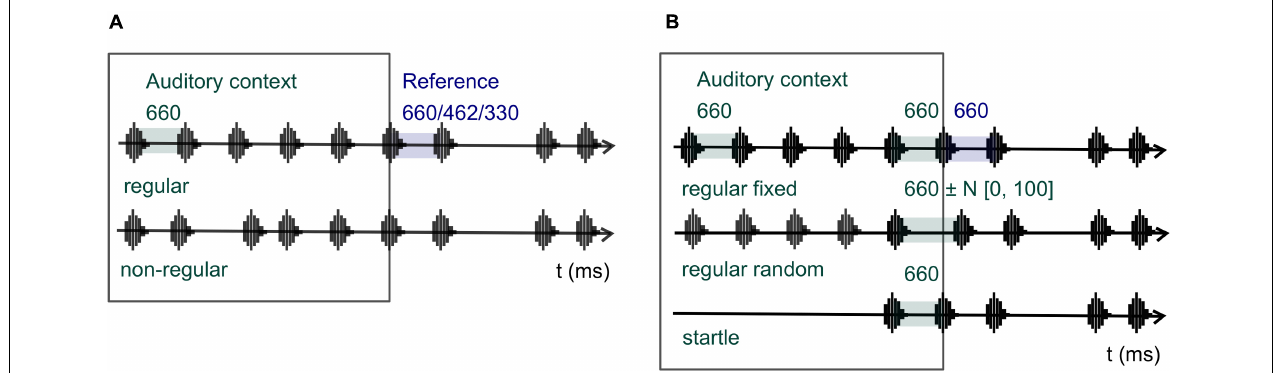
FIGURE 2 | Stimuli of Experiment 1 (A) and Experiment 2 (B) : auditory context made of low-frequency sounds (regions surrounded by squares) and two pairs of high-pitched sounds delimiting the reference and the comparison intervals. The variables of Experiment 1 were auditory context (regular and non-regular) and Reference (660, 462, and 330 ms). In Experiment 2 only auditory context (regular fixed, regular random, and startle) was manipulated, while the duration of the reference interval was fixed to 660 ms.